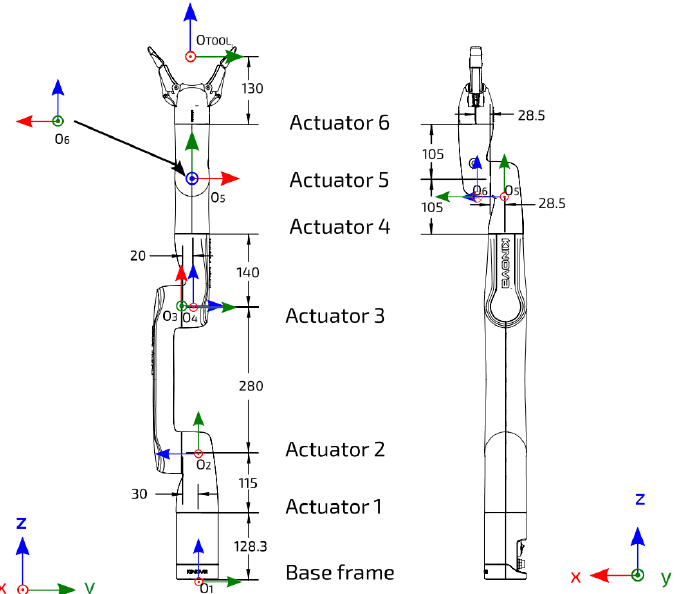
Figure 1. DH frames for each joint with the link dimensions (extracted from the manipulator user